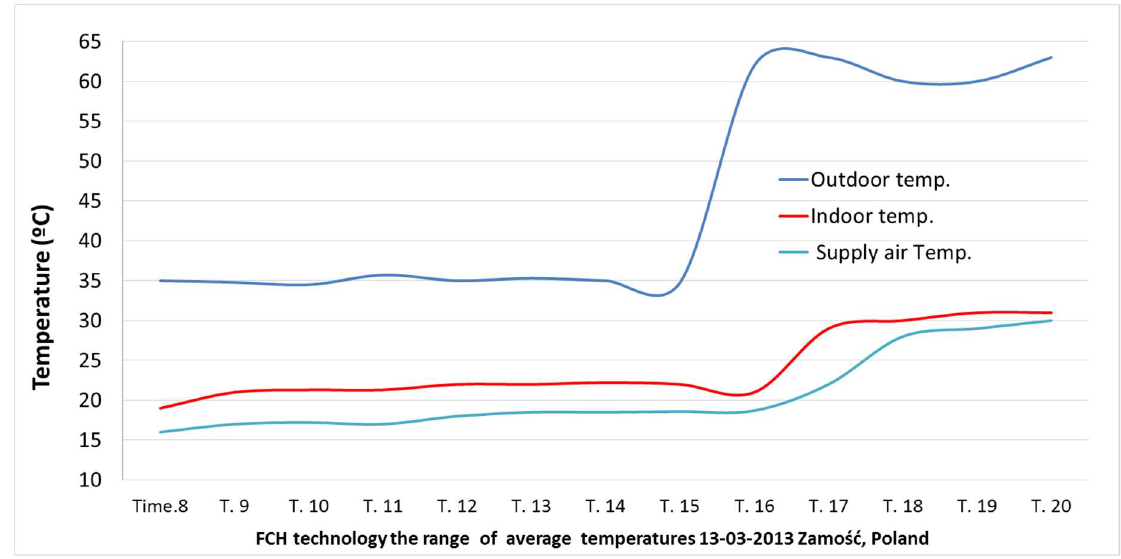
Figure 10. Temperature chart at outdoor temperature Tz = 60 °C, FCH technology, the range of av- erage temperatures (13 March 2013), Zamość, Poland.